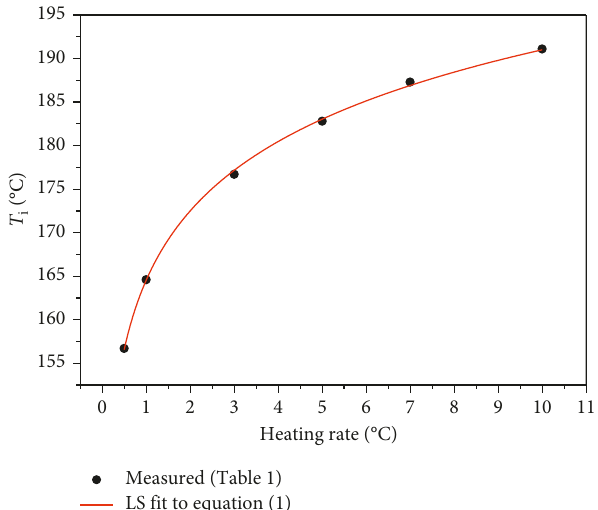
Figure 2: Experimental and fitted dependences of the oxidation onset temperatures on the heating rate (olive oil: C